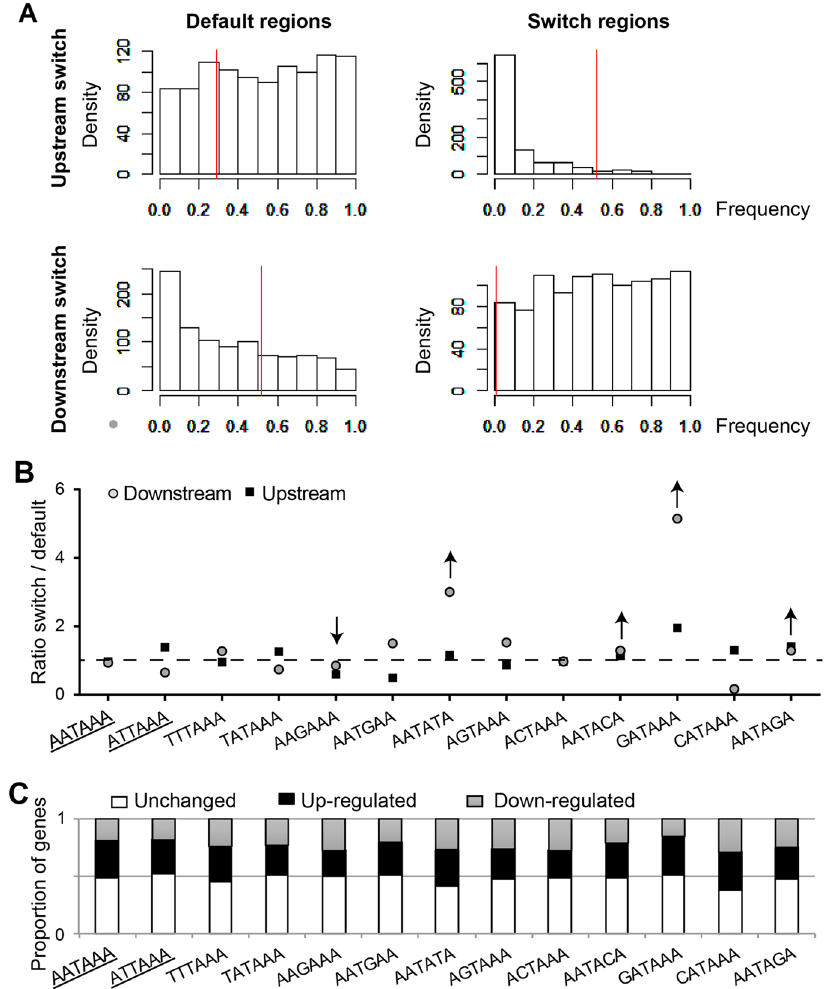
Fig. 7 Utilization of polyadenylation signal motifs in switch regions. a Density histograms of p -values of PAS motif distribution in switch or default PAS regions. Analysis was strati fi ed for downstream and upstream switches. In each group motif frequency was compared to the frequency of all PASs, and statistical signi fi cance was assessed with Pearson ’ s chi-square test. p -values obtained by comparing between motifs distribution in 1000 random subsets of PASs and motifs distribution of all PASs. The red line shows the calculated p -value for each group. b The ratio between switch (A17.1) and default (FVB) PAS utilization regions for 13 polyadenylation signal motifs. Numerical values are shown in Supplementary Table S4. Downstream or upstream switches are depicted by open circles or closed squares , respectively. Hashed line marks ratio = 1. Canonical motifs are underlined. Arrows mark motifs with consistent switches in A17.1 mice: up arrows represents more utilized in A17.1 and down arrow less utilized in A17.1. c Bar chart shows the proportion of genes with up/down or unchanged expression in each PAS